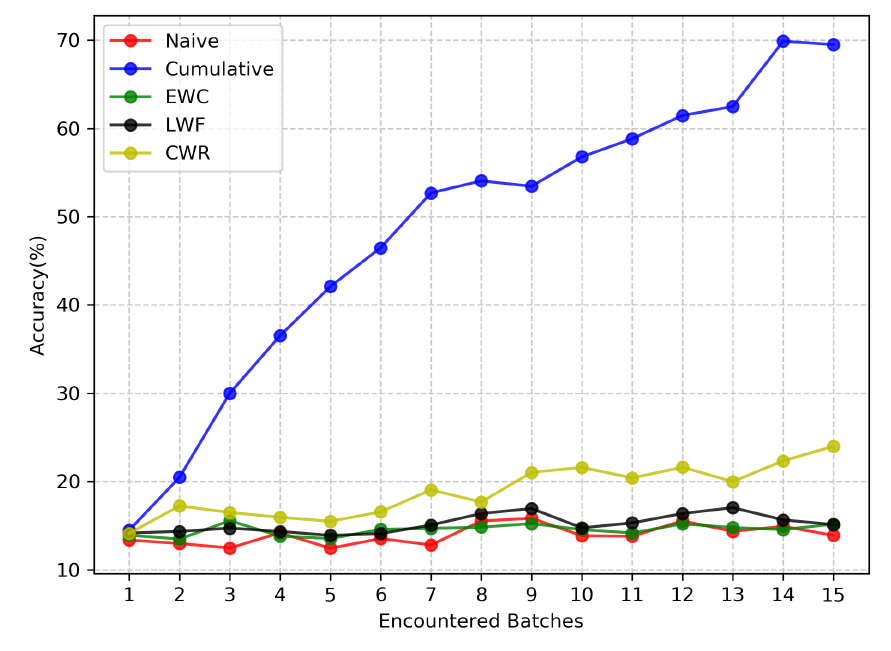
Figure 12. Test accuracy of the five methods on the New Instances and Classes (NIC) scenario. The final result of each method is the average of confusing the training batches order three